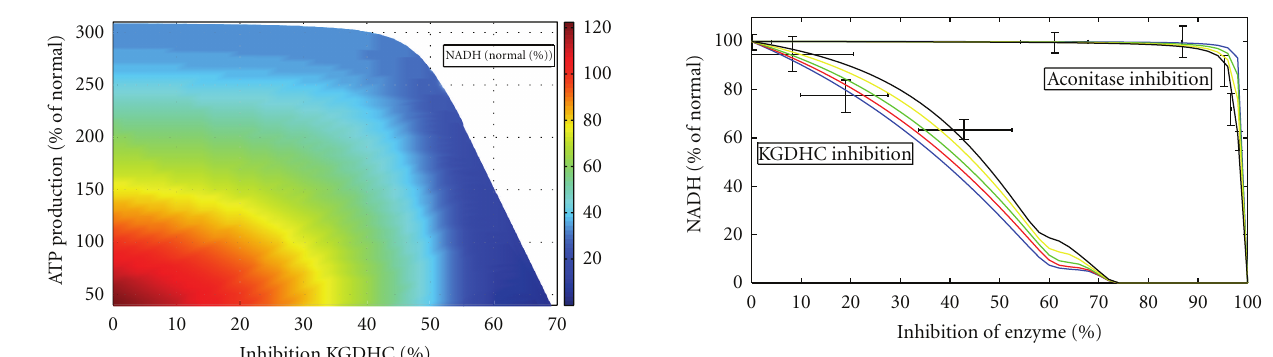
Figure 8: NADH level characteristics at varying ATP demand and KGDHC inhibition. NADH level is depicted as colour value (right scale). NADH level and ATP production are normalized to the reference state without KGDHC inhibition.